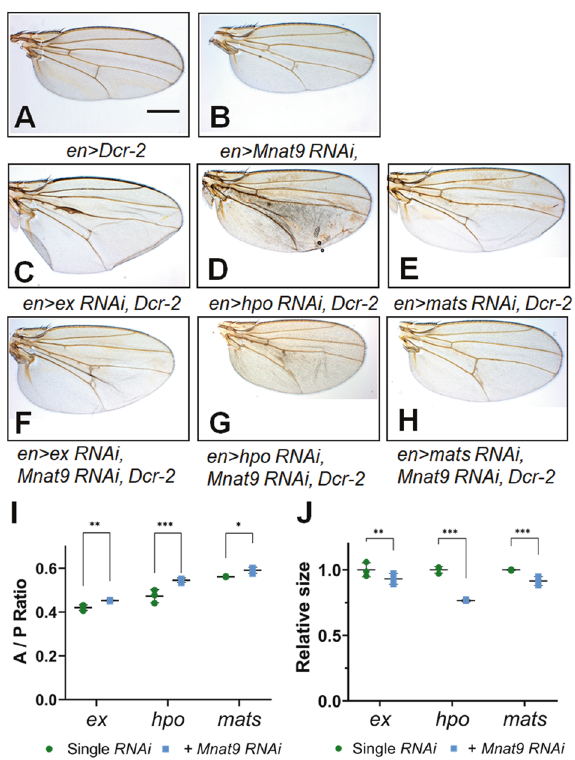
t -test ” was used for statistical analysis. * p < 0.05, ** p < 0.03, *** p < 0.01. Error bars are standard deviations.